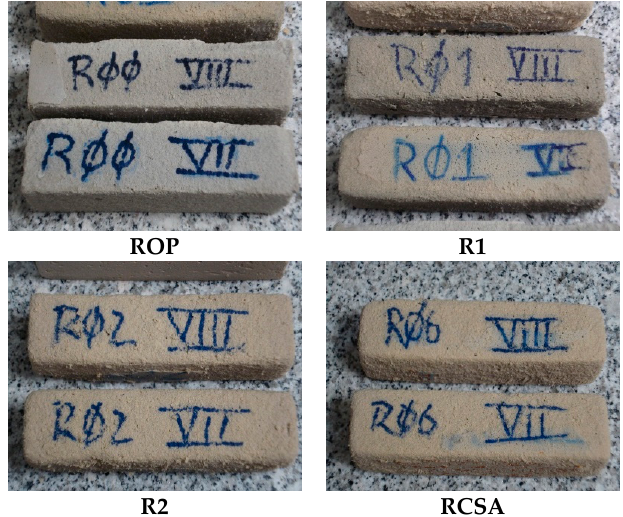
Figure 1. Rendering mortar specimens after freeze-thaw cycles.